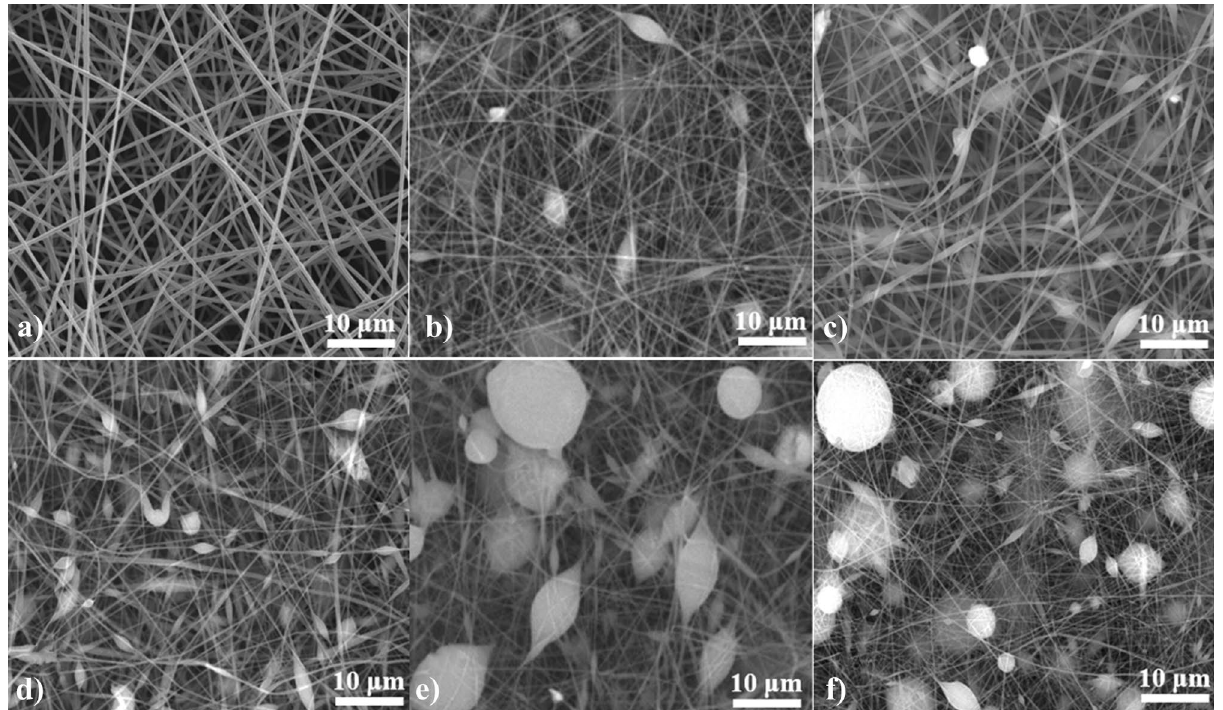
Figure 3. Morphology of PAN/bio-based PU/Ti 3 C 2 T x MXene composite membrane with different Ti 3 C 2 T x MXene contents: ( a ) 0 wt% MXene, ( b ) 0.1 wt% MXene, ( c ) 1 wt% MXene, ( d ) 5 wt% MXene, ( e ) 7 wt% MXene, and ( f ) 10 wt% MXene. Preparation conditions: applied voltage of 26.5 kV, 20 cm distance from the tip to the collector, and solution flow rate of 2